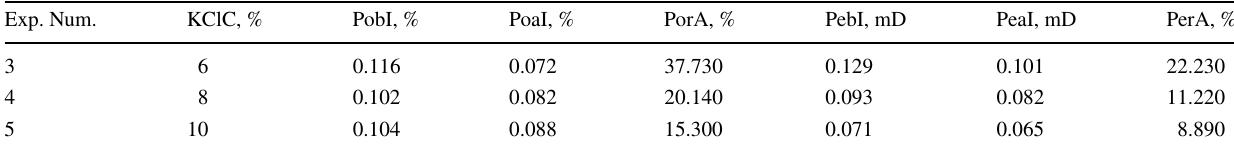
porosity reduce amplitude; PebI is the permeability before imbibition; PeaI is the permeability after imbibition; PerA is the permeability reduce amplitude)